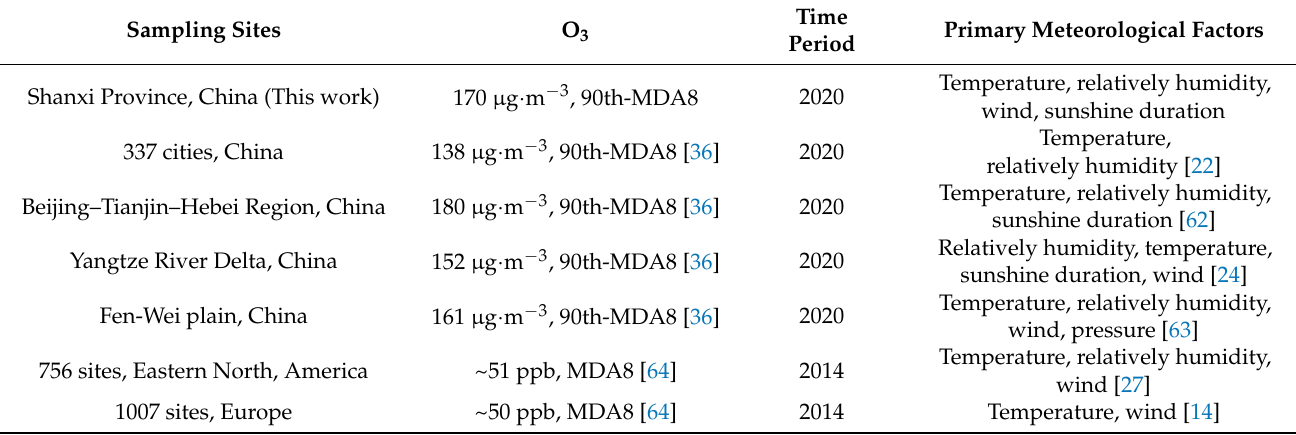
Table 2. Comparisons of O 3 concentration and primary meteorological factors observed at various